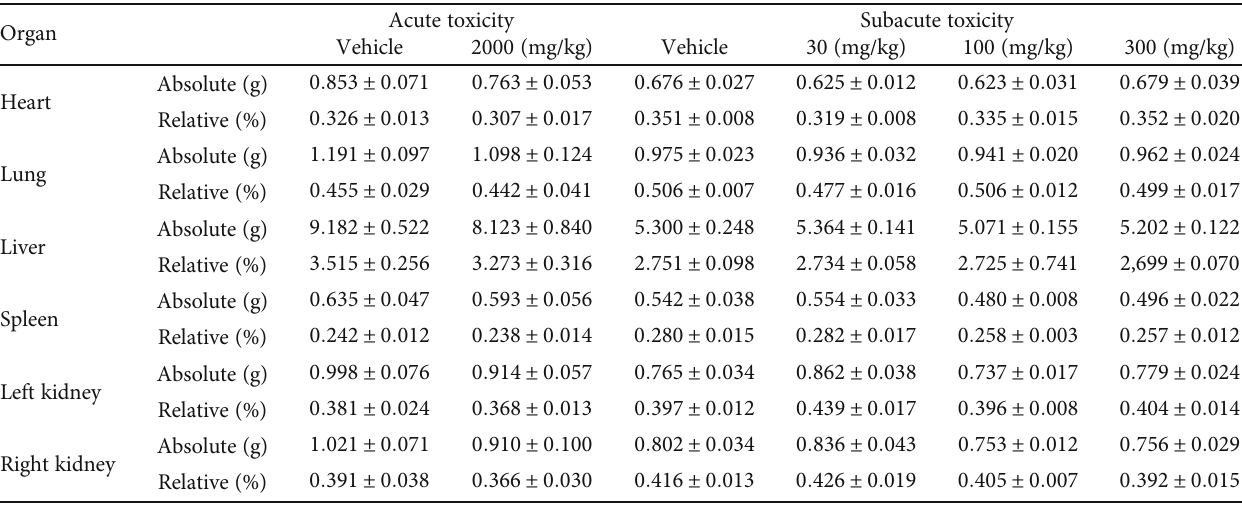
Table 2: E ff ects of Solanum diploconos extract treatment on the organ weights of mice following the acute oral toxicity experiments (values expressed as mean ± SEM ( n = 5 )). Organ